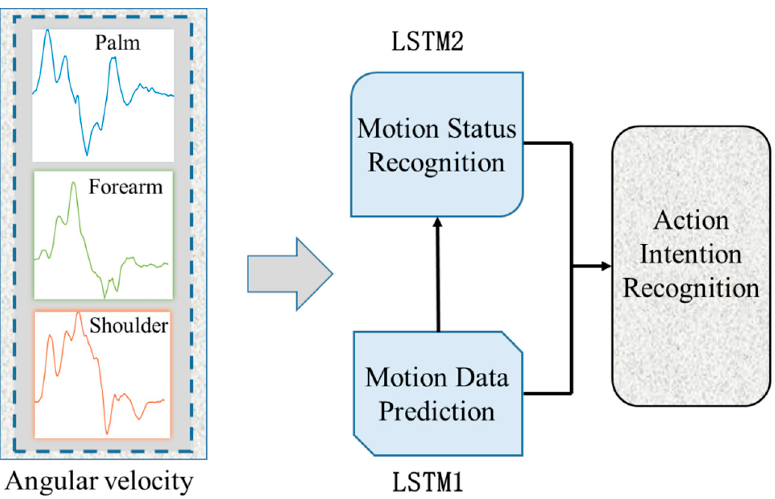
Figure 4. Flowchart of Action Intent Recognition.